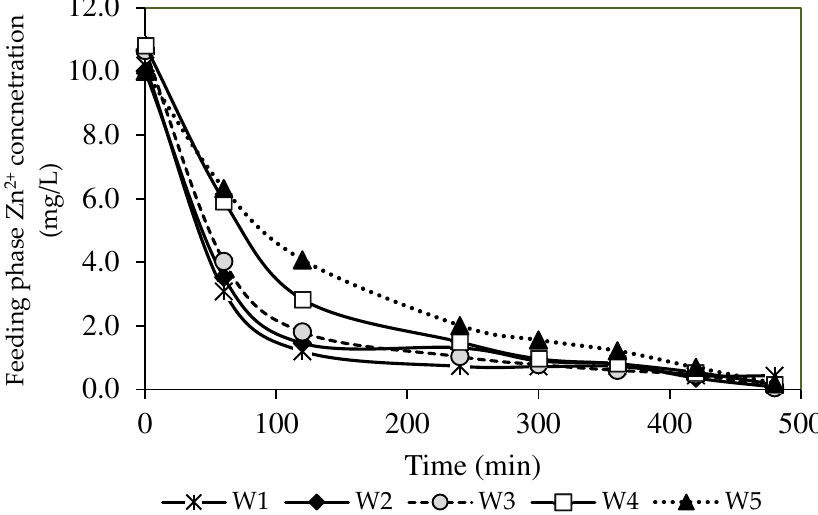
Figure 8. The percentages of Zn 2+ removal of the PIM and MM-PIM samples in the feeding phase.